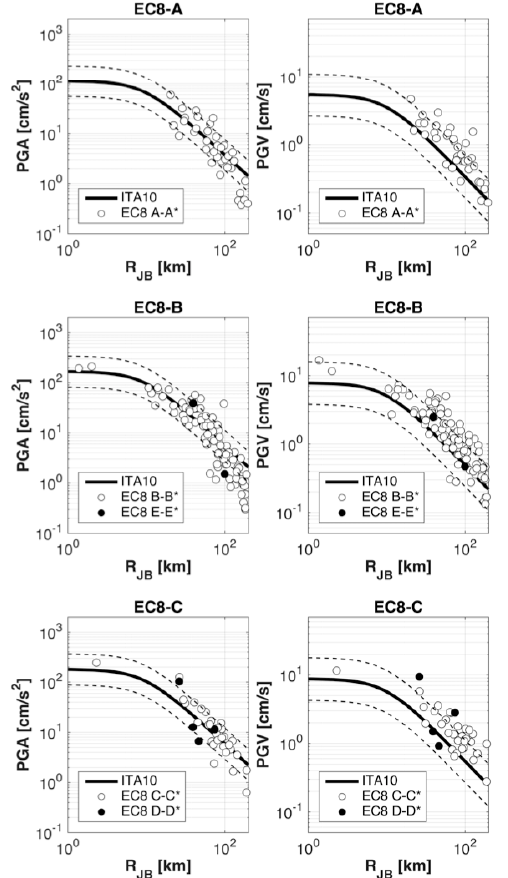
Figure 7 . Observation vs. predictions for the ver- tical component. Left: PGA; right: PGV. Top: EC8 class A; middle: EC8 class B; bottom: EC8 class Figure 6 . Observation vs. predictions for the geo- metrical mean of the horizontal components. Left: PGA; right: PGV. Top: EC8-A; middle: EC8-B; bot- tom: EC8-C. ASB14 predictions are computed us- ing 800 m/s for EC8-A, 580 m/s for EC8-B, 270 m/s for EC8-C.